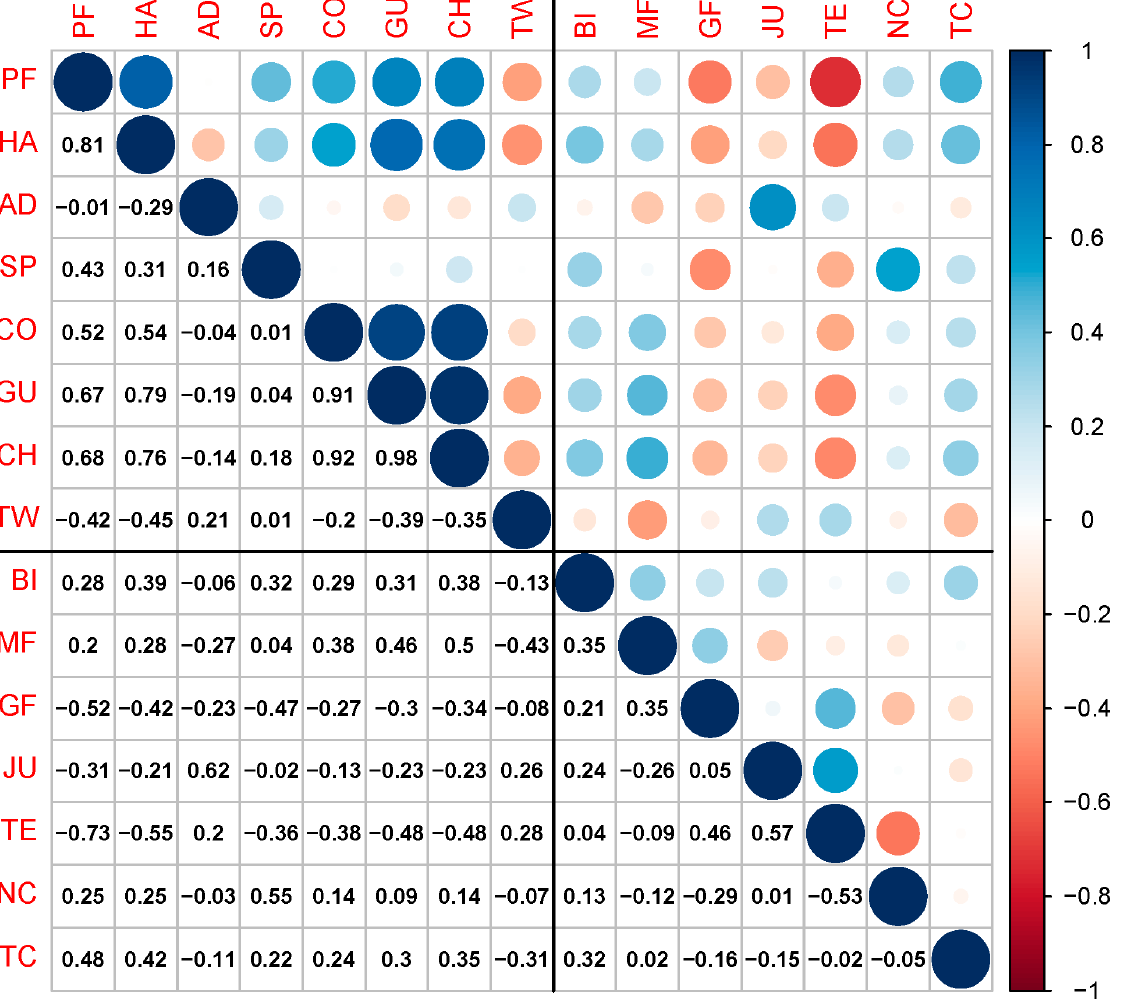
Figure 5. Plot of Pearson correlation coefficients ( r ) of sensory attributes (BI = beef identity, MF = metallic flavour, GF = ginger flavour, JU = juiciness, TE = tenderness, NC = number of chew, TC = textural consistency; evaluated through trained panellists) and physical measurements (PF = peak force, HA = hardness, AD = adhesiveness, SP = springiness, CO = cohesiveness, GU = gumminess, CH = chewiness and TW = total water content) for M. biceps femoris in control (without injection) and ginger powder injection samples cooked for 8 h and 12 h at 65 °C under sous vide. Correlation values are shown below the diagonal, and colour coding for size and sign of correlations are shown above the diagonal. Blue dots indicate positive correlations and red dot represents the negative cor- relations among the traits.